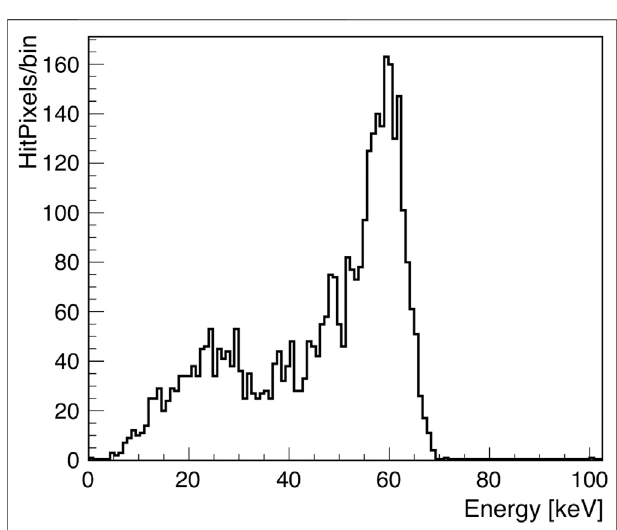
Frontiers in Physics |